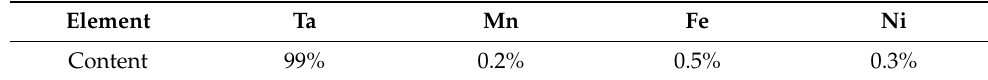
Table 6. The metals compounds of TaCl 5.